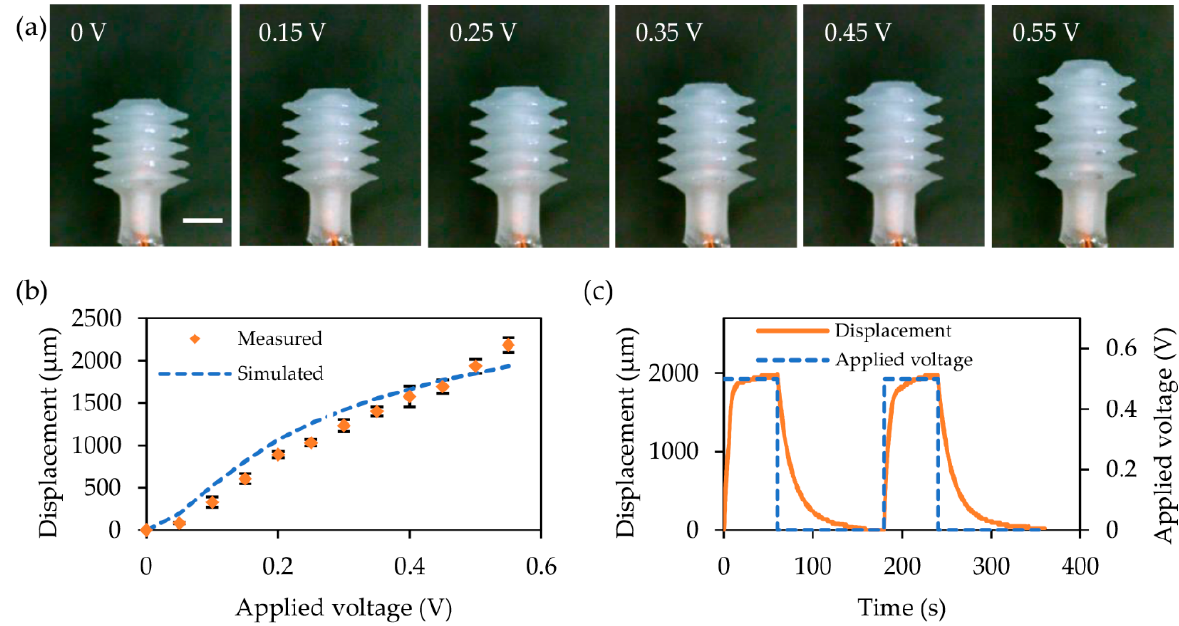
Figure 5. Displacement response generated by Joule heating. ( a ) Images of a thermopneumatic bellows actuator in stop motion due to a voltage applied at 0.10 V intervals from 0 V to 0.55 V. The scale bar is 2.0 mm. ( b ) Steady-state displacement of thermopneumatic bellows actuator versus applied voltage to the heater. Voltage was applied to the heater at intervals of 0.05 V up to the maximum operating voltage of 0.55 V. ( c ) Displacement of thermopneumatic bellows actuator when two cycles of 0.50 V pulse voltage with 180 s, duty ratio of 33% were